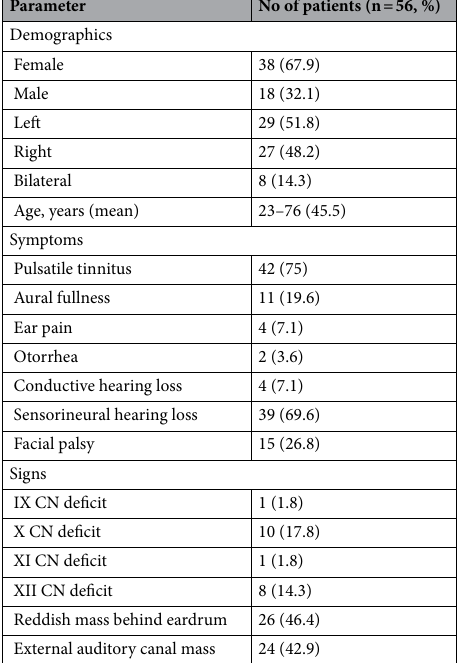
Table 1. Preoperative characteristics of patients with JPs. CN cranial nerve.